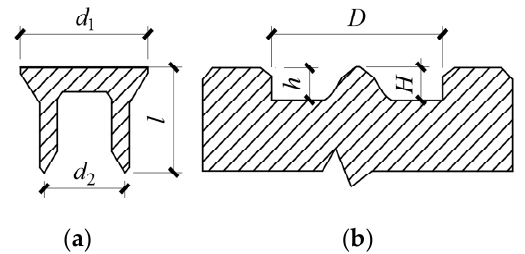
Figure 3. Size definition of the rivet and the bottom die: ( a ) rivet, ( b ) bottom die. Table 1. Parameters of CFS-SPR connection specimens.